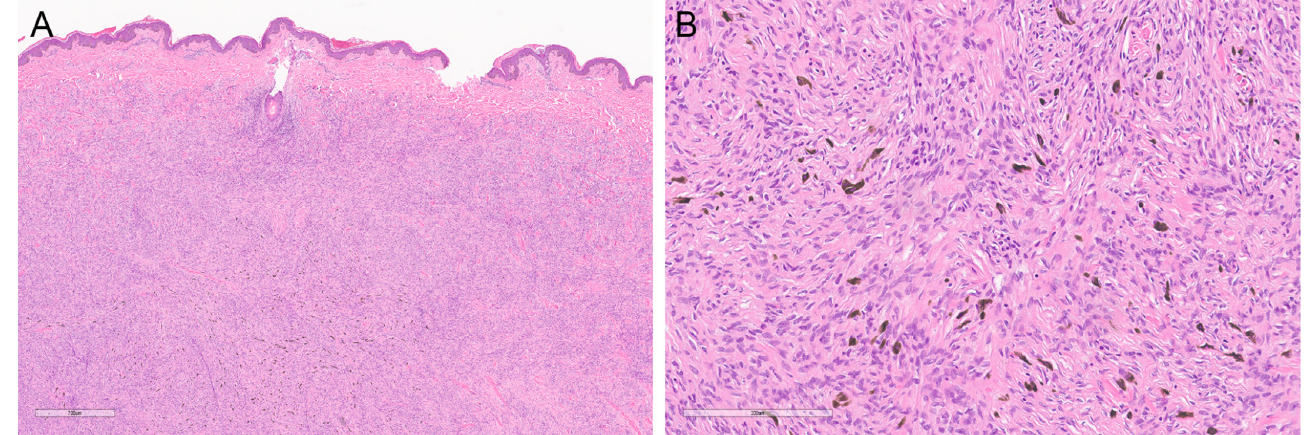
Figure 3. Pigmented DFSP (Bednar tumor). Occasionally, DFSP can show areas of melanocytes containing melanin pigments (( A ); magnification × 40 and ( B ); magnification × 200). The tumor otherwise shows characteristic features of DFSP. This feature has no prognostic